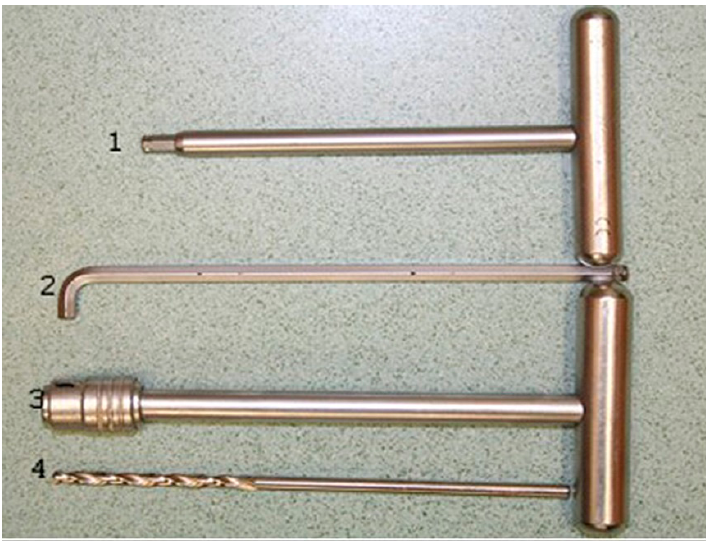
Figure 5. Assembly tools and drill bit; ( 1 ) Straight hex key, ( 2 ) bent hex key, ( 3 ) pin inserter, ( 4 ) drill bit with a diameter of 4.5 mm.